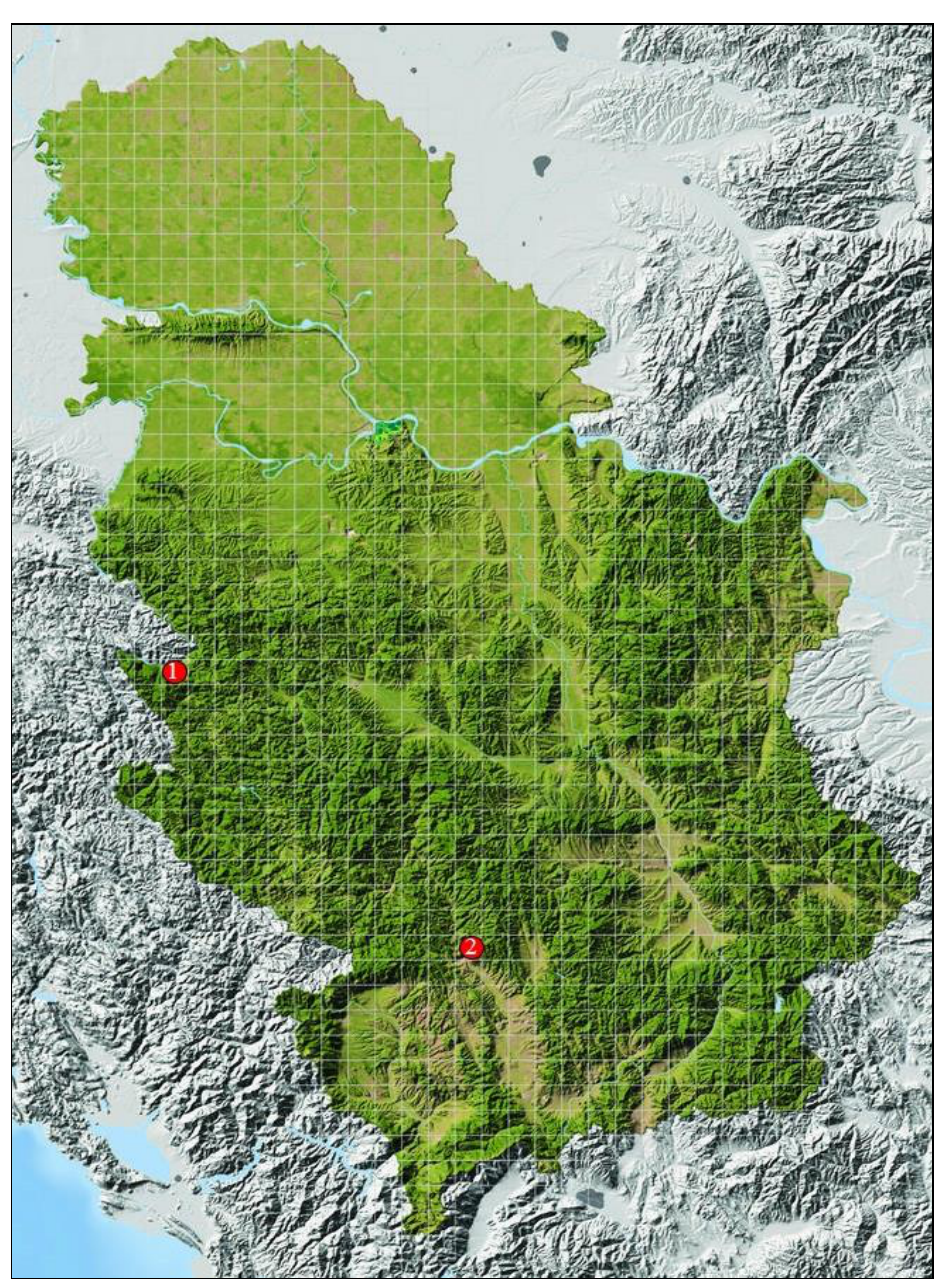
Figure 2. Distributiоn of Lumbricus meliboeus in Serbia (1 − literature data; 2 − new